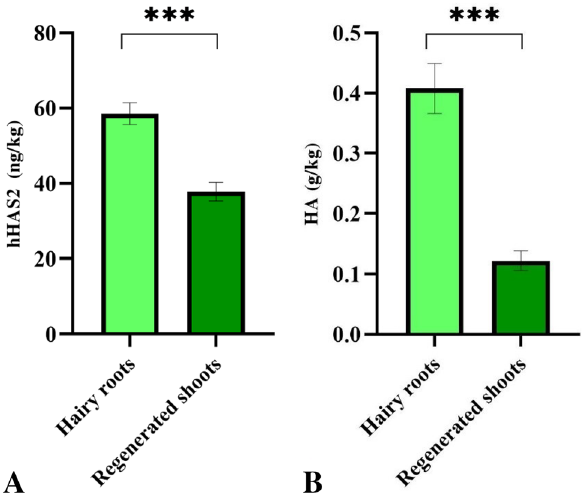
Organism HAS source Table 5. Engineered organisms for HA production . ***Information was not available.